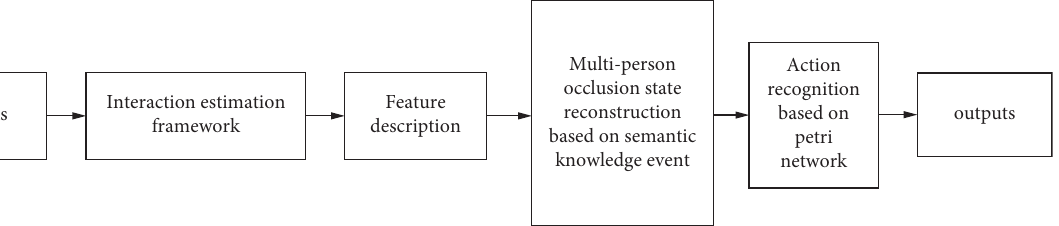
Figure 1: Proposed multiperson interactive activity recognition. The data comes into the framework on the left. The interaction relation estimation framework and multiperson relation graph network represent the multiperson scene. Secondly, we extract feature description based on the 3D extension to the SIFT algorithm. Thirdly, multiperson occlusion state reconstruction based on the semantic knowledge event is used to describe multiperson interactive behavior events. Finally, we introduce Petri Nets (PNs) for detecting activities in four public datasets.